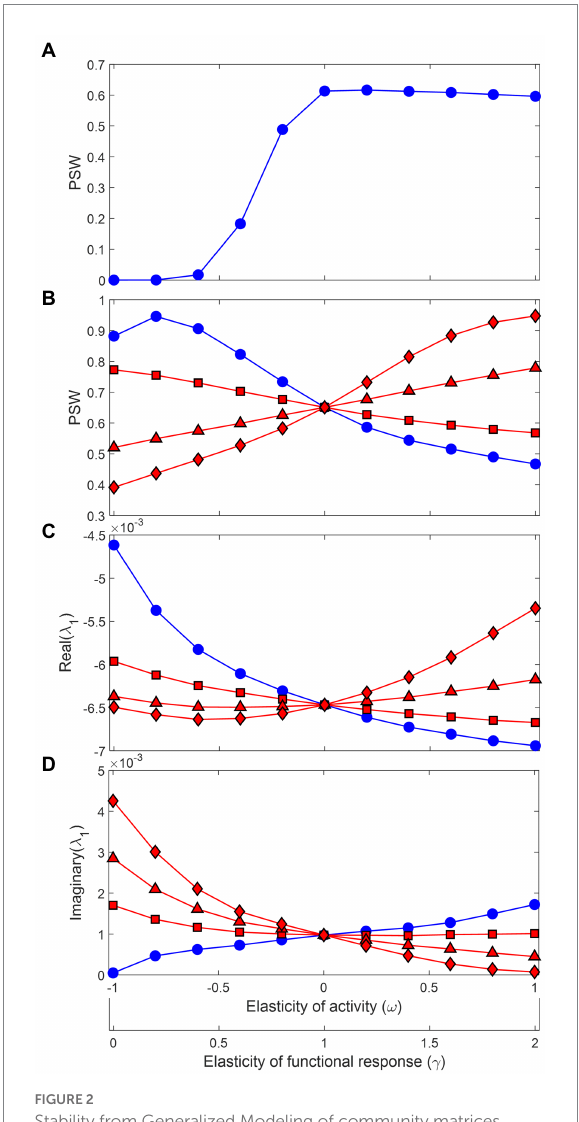
FIGURE 2 Stability from Generalized Modeling of community matrices generated by 10 6 random parameter combinations. The x-axis represents changes in the elasticity of foraging activity with respect to prey density ( ω ), from inversely proportional ( 1 ω= − ) to proportional ( 1 ω= ). It also shows the associated change in the elasticity of the functional response ( γ ), from a completely saturated functional response